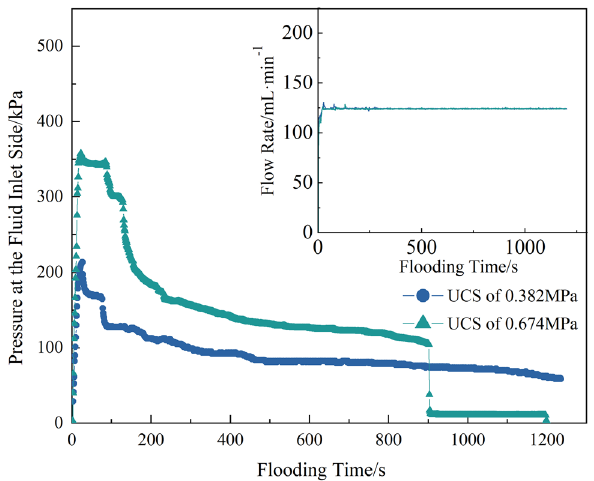
Fig. 11 Pressure at the fluid inlet side corresponding to the multi- branch sand production patterns in trapezoidal models